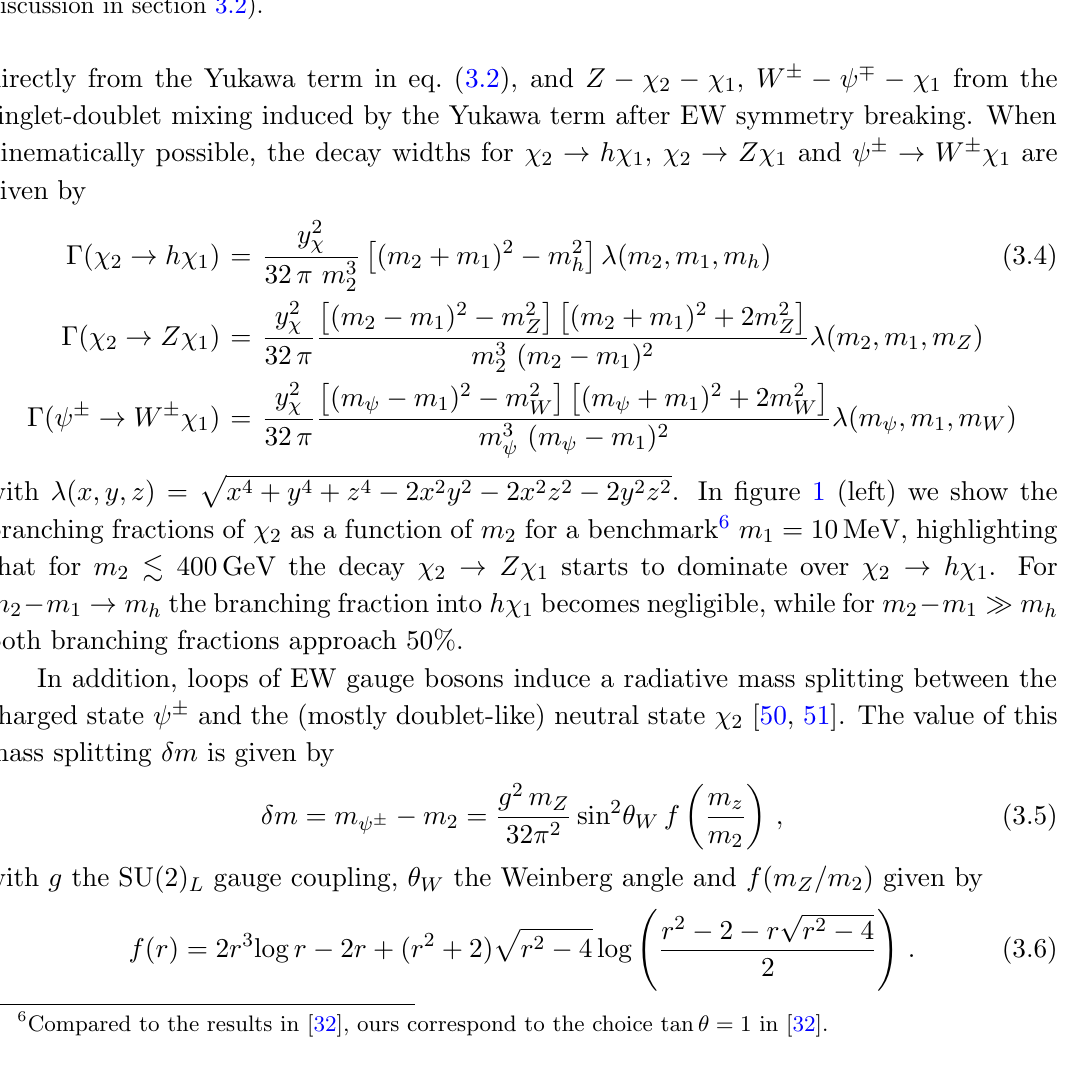
Figure 1 . Left: branching fractions for (cid:31) 2 for m 1 = 10 MeV. Right: branching ratio BR( (cid:6) mass m 1 = 12 KeV. The solid black line corresponds to (cid:10) with micrOMEGAs5.0 [49] (assuming an EW phase transition temperature T EW = 160 GeV, see the discussion in section